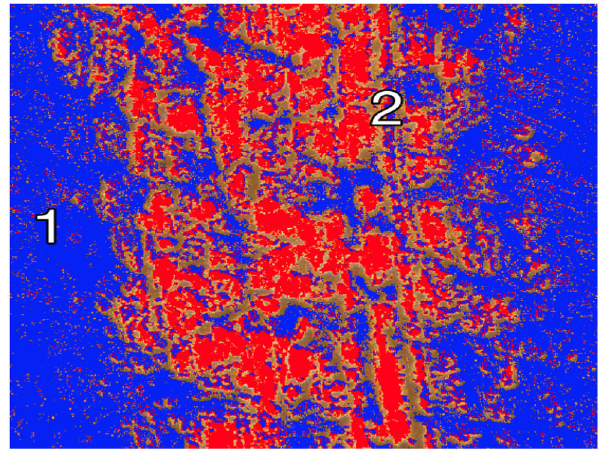
Fig. 10 Highlighted optical micrograph of polished wear track of sample CpC25.